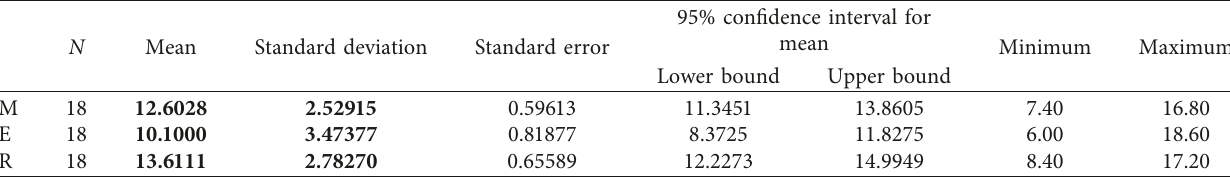
Table 1: Descriptive statistics for the learners’ scores in uptake.